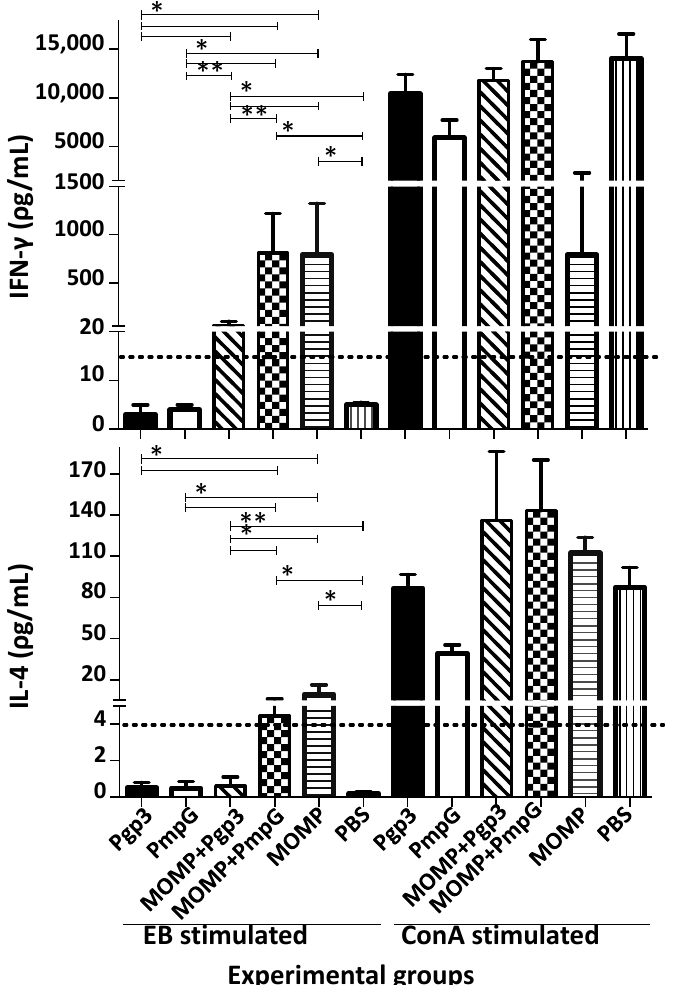
Figure 7. Evaluation of the cytokine responses from T-cells isolated from the spleens of vaccinated mice the day before the i.n. challenge. Spleens from four mice from each immunized group were collected the day before the i.n. challenge, T-cells separated with nylon wool and stimulated with C. muridarum EB, and ConA as a positive control. Levels of IFN- γ (pg/mL ± SE) and IL-4 (pg/mL ± SE) were determined as indicators of Th1 and Th2 responses, respectively. * p < 0.05 by the Mann–Whitney’s U -test. ** p < 0.1 by the Mann–Whitney’s U -test. BLD (horizontal broken line) IFN- γ < 15 pg/mL; IL-4 < 4